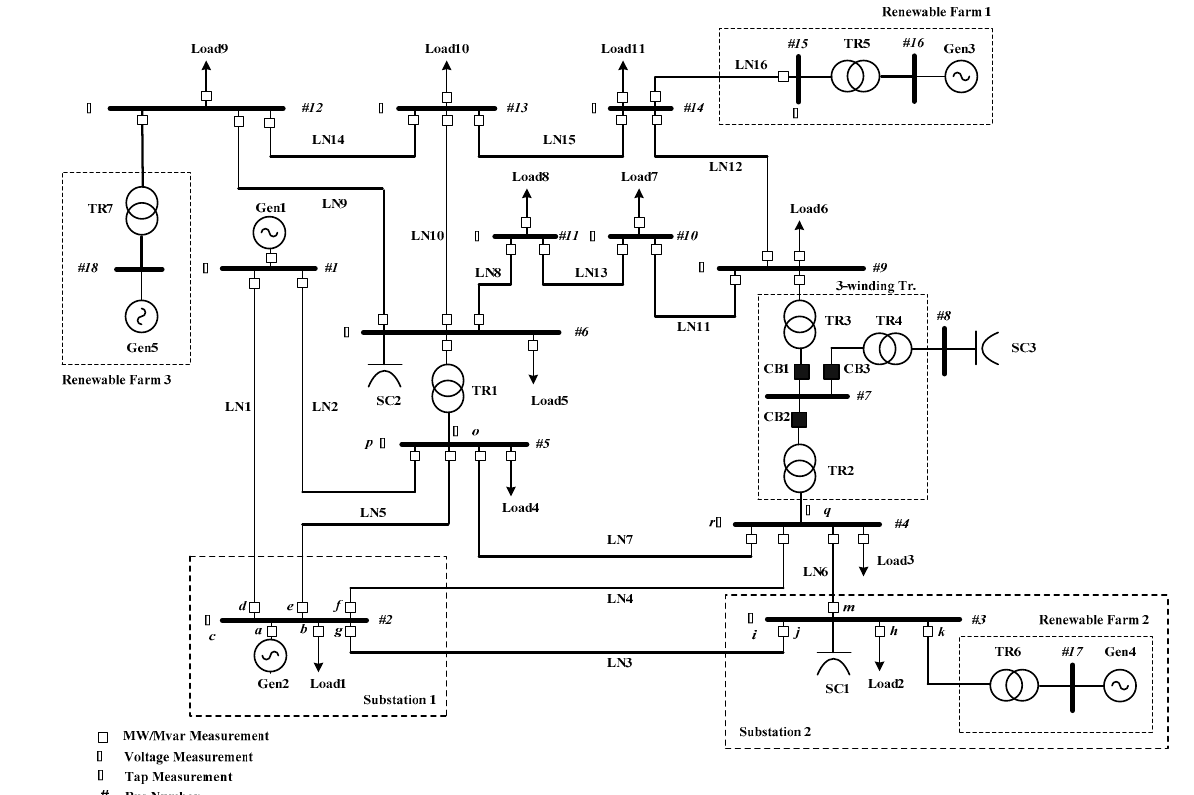
Figure 8. Modified IEEE 18-bus test system including renewable energy. Table 4. Scenario for validating the state estimation algorithm.